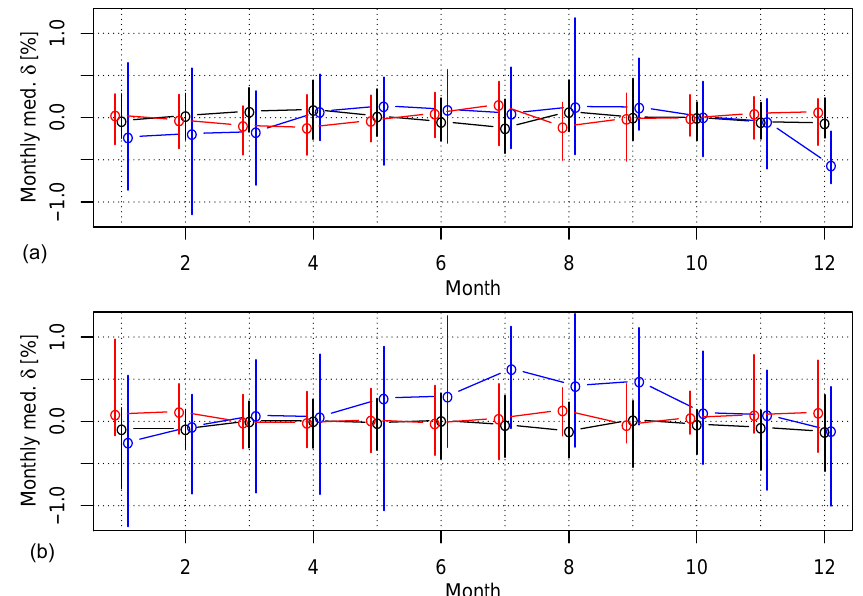
Figure 9. Seasonal cycle of the offset δ for Brewer B 040 , B 072 and B 156 instruments in red, blue and green, respectively. Panel (a) corresponds to the Arosa period, while (b) corresponds to the Davos period. The bars correspond to the interquantiles Q 97 . 5% – Q 2 . 5%